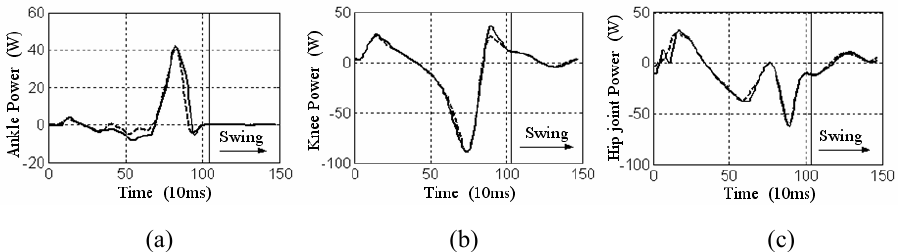
Fig. 6. Joint powers estimated by wearable sensor systems (solid line), and force plate & Hi-DCam camera systems (dashed line). (a) Ankle powers. (b) Knee powers. (c) Hip joint